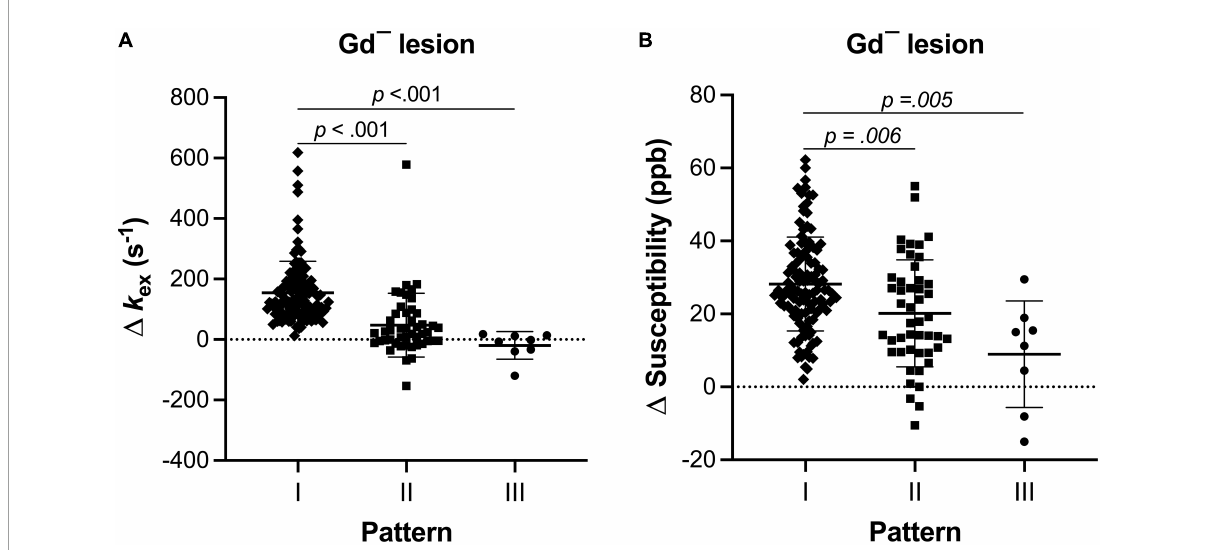
FIGURE6 The level of inflammation indicator of each pattern of Gd – MS lesions was different (Kruskal–Wallis test with Dunn-Sidàk correction). Compared with Pattern II and Pattern III, Pattern I also showed higher k ex elevation (A) and higher susceptibility elevation (B)